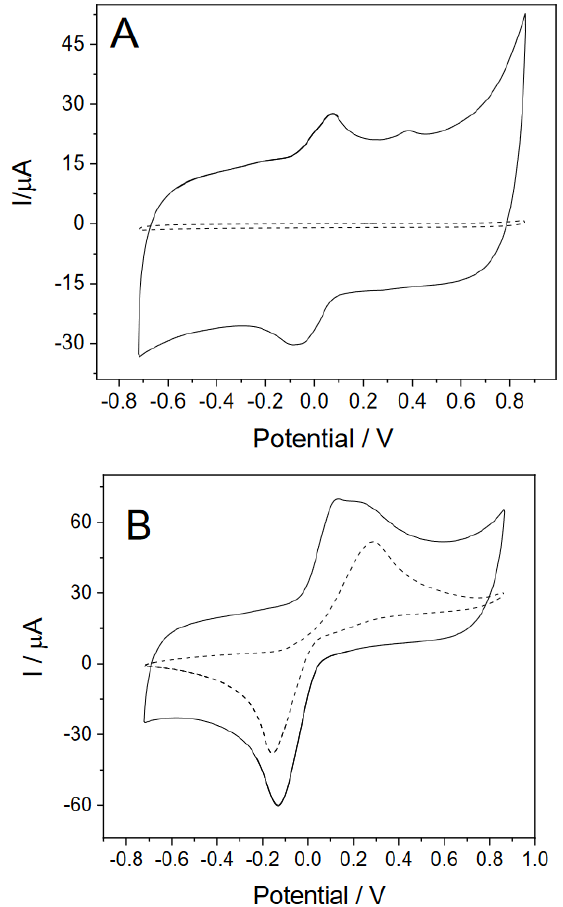
Figure 1. Stabilized cyclic voltammogram of pristine SPE carbon electrode (dashed lines) and AETAC- modified electrode in 0.1 M trizma buffer solution (pH = 8.4) in the absence ( A ) and presence ( B ) of 1 mM HQ at 100 mV s − 1 and room atmosphere. Potentials are referred to the Ag pseudoreference electrode of the